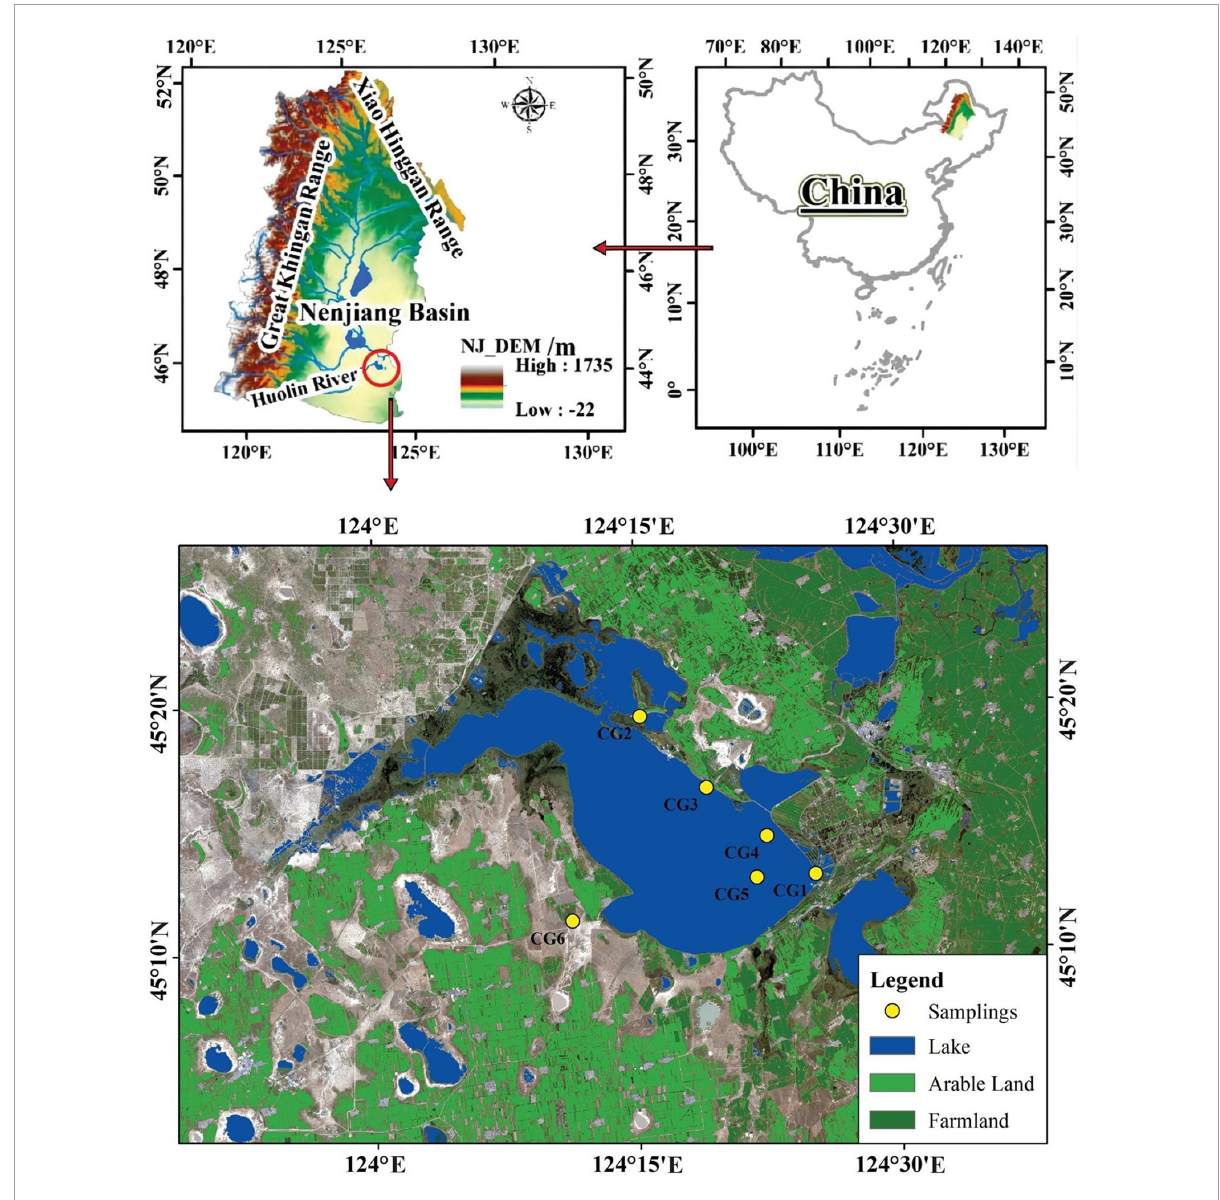
FIGURE2 Location of Chagan Lake and sampling